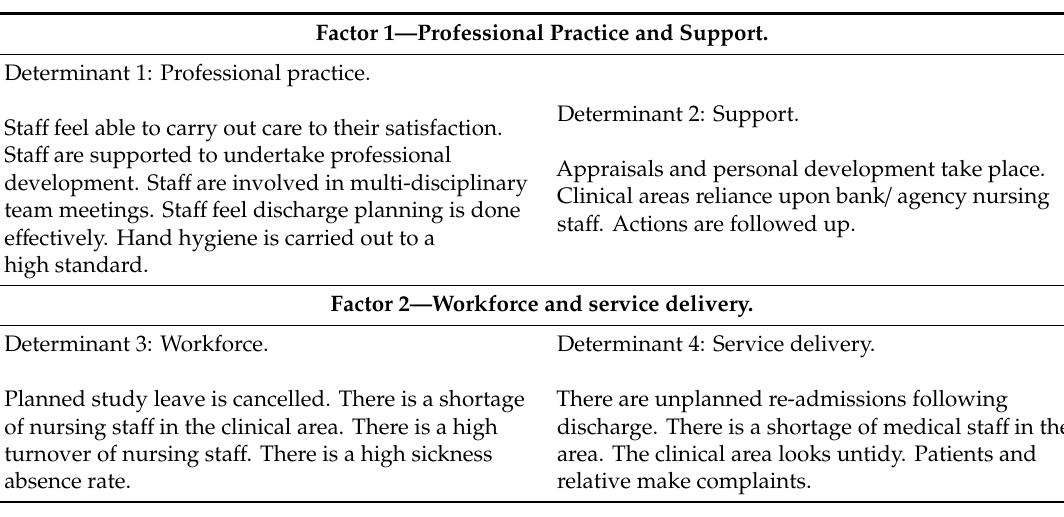
Table 3. Determinants of organisational culture